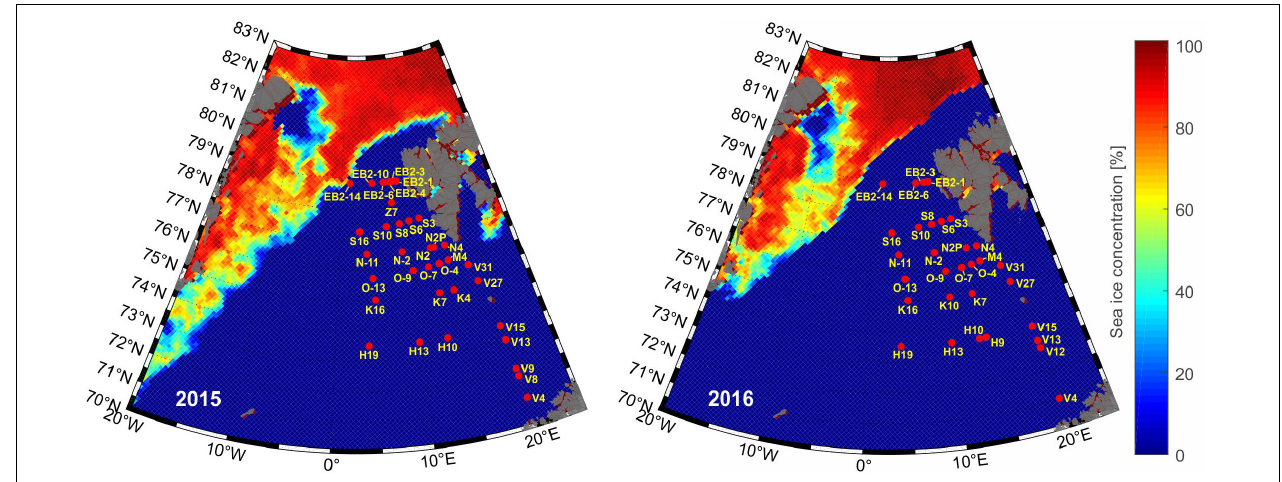
FIGURE 1 | The sampling station locations in the summers of 2015 and 2016. The satellite remote sensing sea ice concentration data (5-day median calculated for a sampling day closest to the ice) were obtained from https://nsidc.org/ (Cavalieri et al., 1996, updated